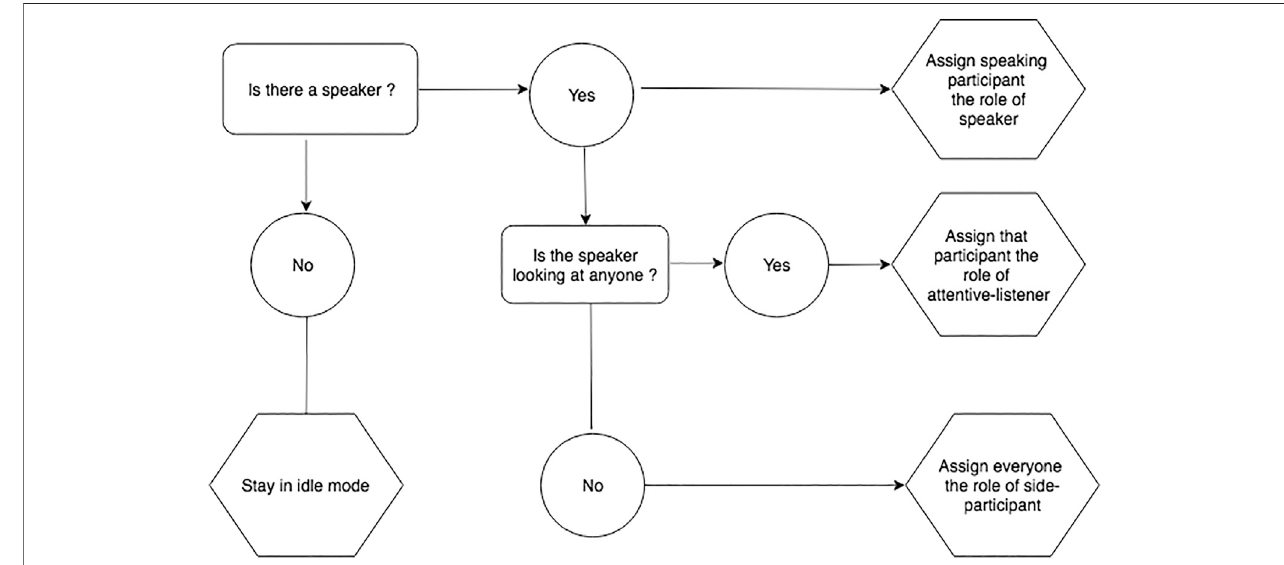
FIGURE 5 | Rules for assigning listener categories: General case.